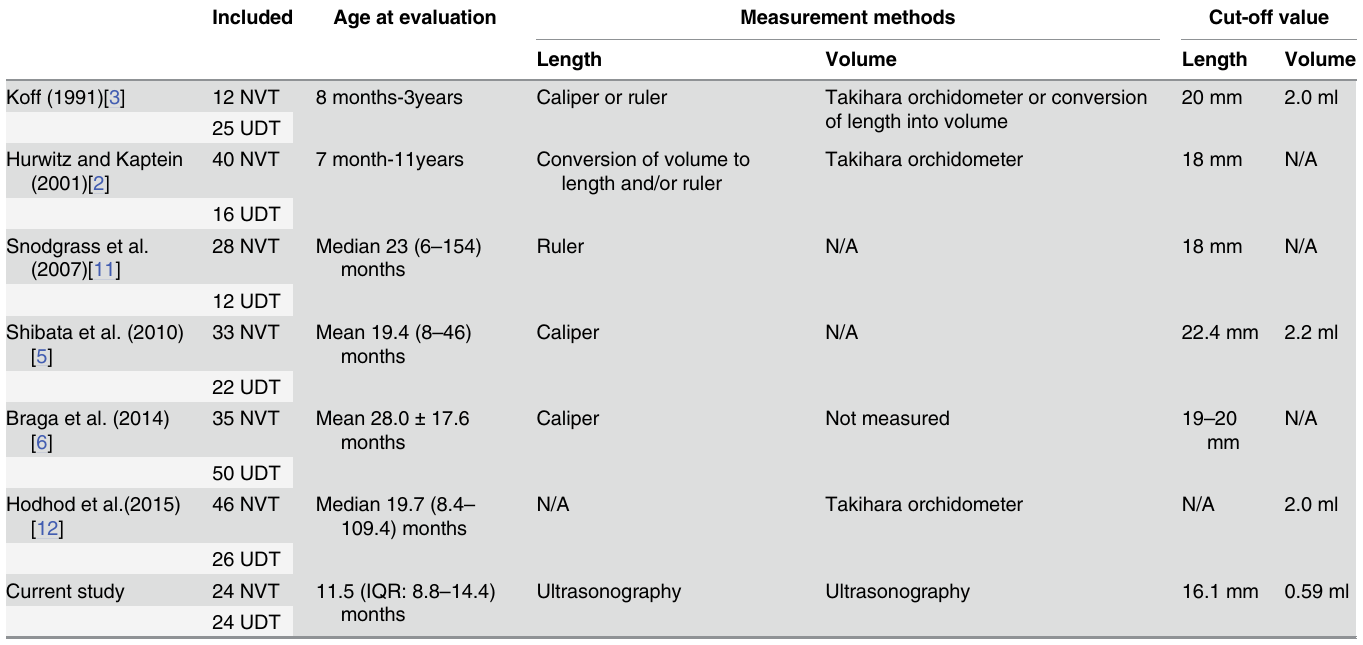
Table 2. Cut-off level for testicular length and volume reported